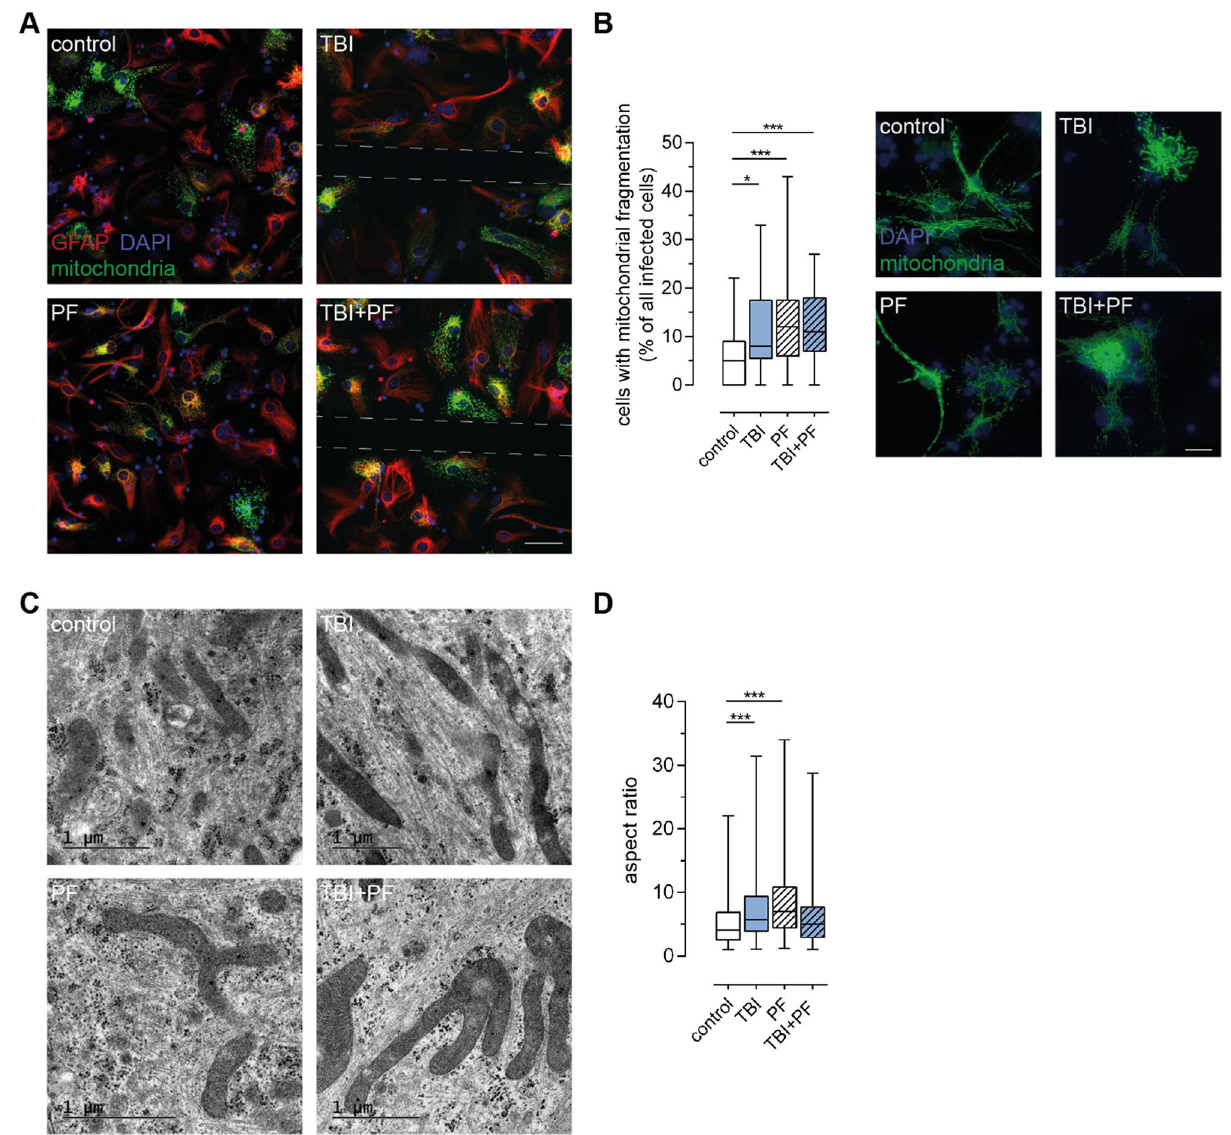
Figure 5. TBI and Aβ 42 protofibril exposure cause mitochondrial damage in astrocytes. ( A ) The health of mitochondria in astrocytes (GFAP) in response to the TBI and Aβ 42 protofibril exposure was investigated. Representative images show mitochondria labeled with CellLight Mitochondria-GFP and cell nuclei with DAPI. The sites of the injury are indicated by the dashed lines. ( B ) Mitochondrial network fragmentation was assessed and quantified. While control cells possess a predominately healthy-looking mitochondrial network with strands of branching mitochondria, exposed cells display various states of mitochondrial network disruption. Increasing fragmentation can be observed and at late stages defective mitochondrial membranes causes the release of labeled mitochondrial proteins that become visible in the cytosol. Fifteen images per independent cell culture (n = 3) and experimental group were analyzed and reported. ( C ) Representative TEM images showing examples of mitochondria observed in control cells and cells undergone TBI, Aβ 42 protofibril exposure or the combination of both. Abnormal fusion events were primarily observed in exposed cells and some mitochondria possessed marked lesions. ( D ) Quantification of the aspect ratio (mitochondrial length/width) confirmed these observations. Five cells per experimental group were analyzed; quantifying the mitochondria in a total of 55–68 TEM images per group. Statistical analyses were performed with the Kruskal–Wallis test followed by